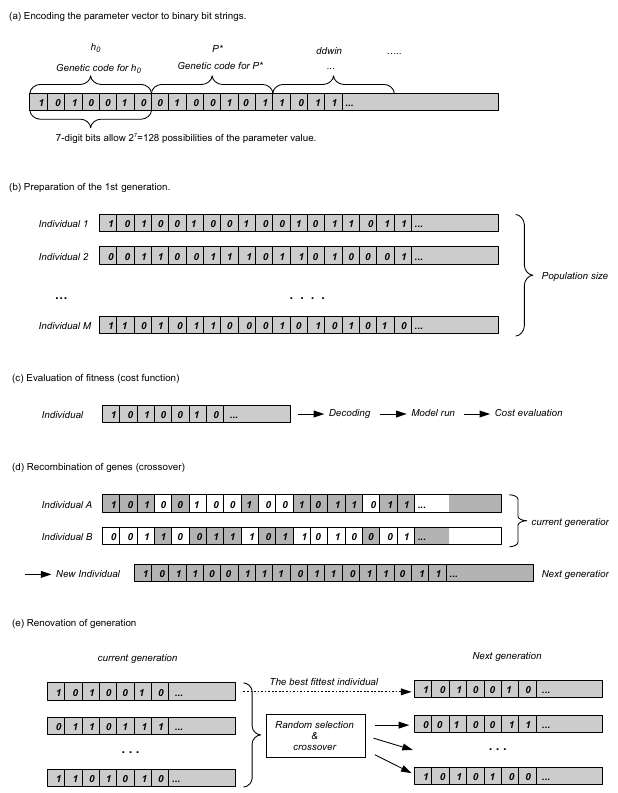
Fig. 3. Schematics of key processes in genetic algorithm: (a) en- coding the parameter vector to binary bit strings, (b) preparation of generation, (c) evaluation of fitness of each individual, (d) re- combination of genes and (e) renovation of generation. See text for